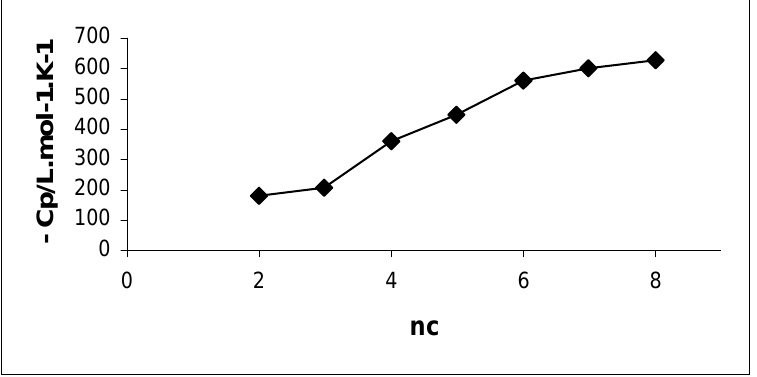
Figure 8. ∆ Cp° for the binding of alcohols to α -cyclodextrin against the number of carbon atoms, n c